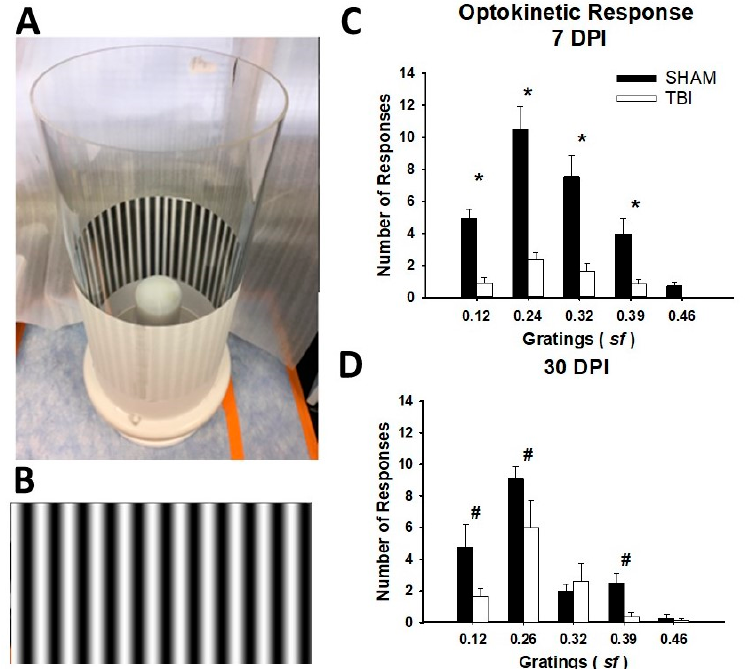
Figure 3. TBI/iTON mice have significantly blunted optokinetic responses. The number of responses were totaled for both left and right directions are represented as mean ± SEM for each spatial frequency analyzed. ( A ) Photograph of the behavioral testing apparatus. ( B ) Shows an example of a visual grating as used in this test. ( C ) Optokinetic responses at 7 DPI. ( D ) Optokinetic responses at 30 DPI. * p < 0.001 and # p < 0.005 vs. sham at the same grating size.